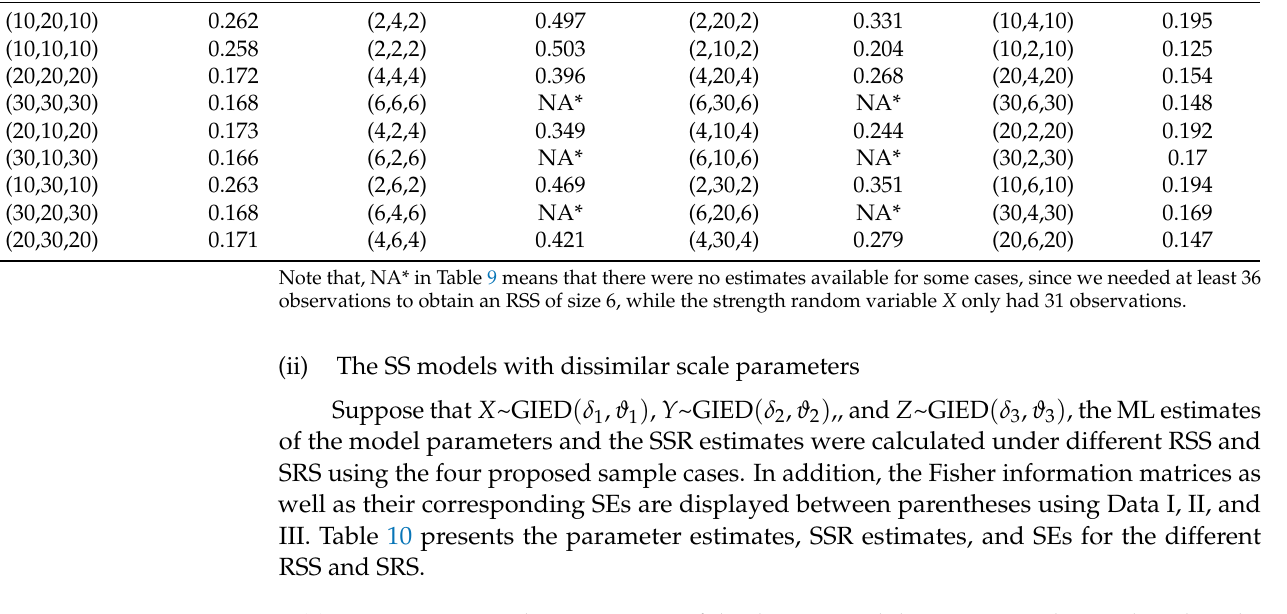
Table 10. Parameter and SSR estimates of the data sets and their corresponding SE based on the different sampling